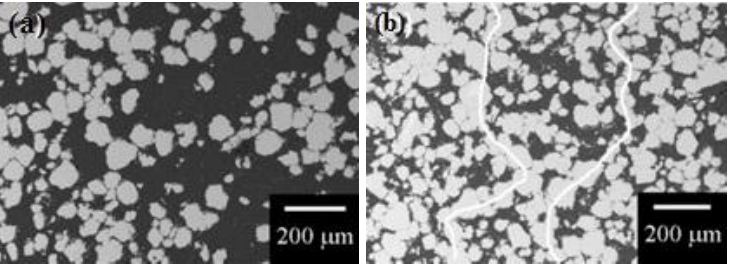
Figure 5. Scanning electron microscopy (SEM) micrographs of ( a ) 40 vol% and ( b ) 60 vol% Zr-based glassy particles reinforced Al-matrix composites. White lines in ( b ) represent the continuous network of particles, (reprinted from Scudino et al . 2009 [8], with permission from © Elsevier).